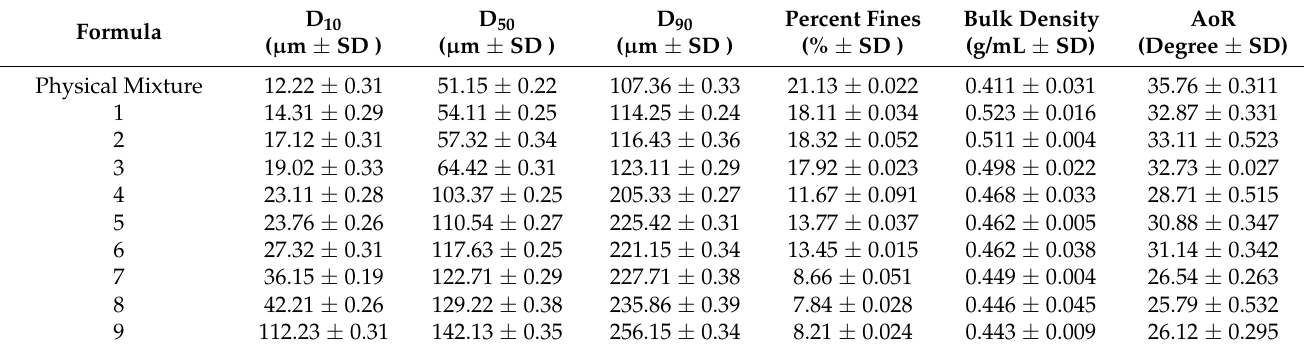
Table 5. Measured response results of physical mixture and prepared granules (mean ± SD).